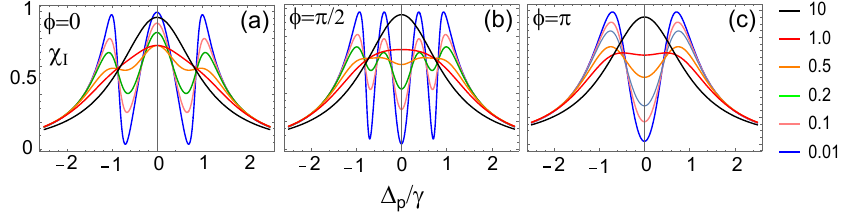
Figure 2. (Color online) Absorption Im χ ( ∆ p ) versus ∆ p /γ is shown with Ω O 1 = Ω O 2 = Ω m 1 = Ω m 2 = 1 γ and with (a) φ = 0 (triplet), (b) φ = π/ 2 (quartuplet) and (c) φ = π (doublet). The dephasing decay rates γ i = 1 , 2 , 3 are selected as 0 . 01 γ (blue), 0 . 1 γ (pink), 0 . 2 γ (green), 0 . 5 γ (orange), 1 . 0 γ (red), 10 γ (black). The behaviour of the system with the dephasing rates 0 . 01 γ and 0 . 5 γ are typical examples of the EIT and the ATE in each case of the relative phase φ ,